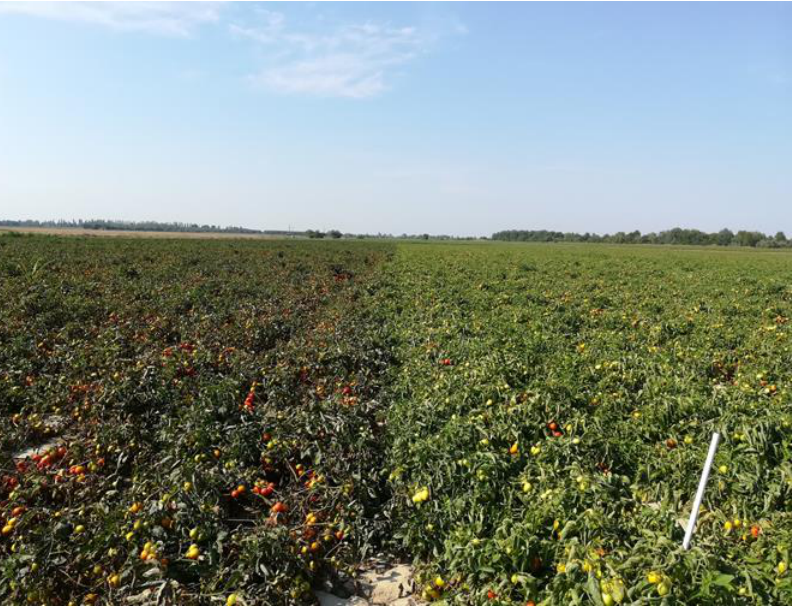
Figure 2. Comparison of late blight (dark coloring) on tomato leaf tissue (disease rating of 79%) between the nontreated control plot (left) and the horsetail macerate-treated plot (disease rating of 36%, right) on July 26 2019.